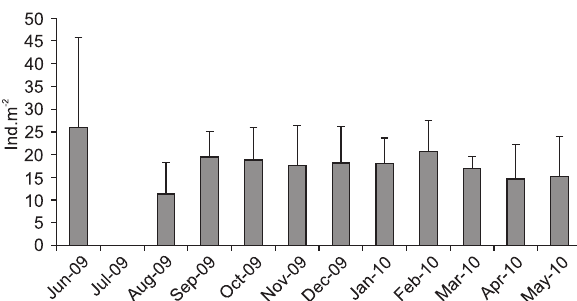
period.Figure 1. Temporal variation of the density of Scolelepis goodbodyi (monthly means), from June 2009 to May 2010. Note: vertical bars represent the standard error.